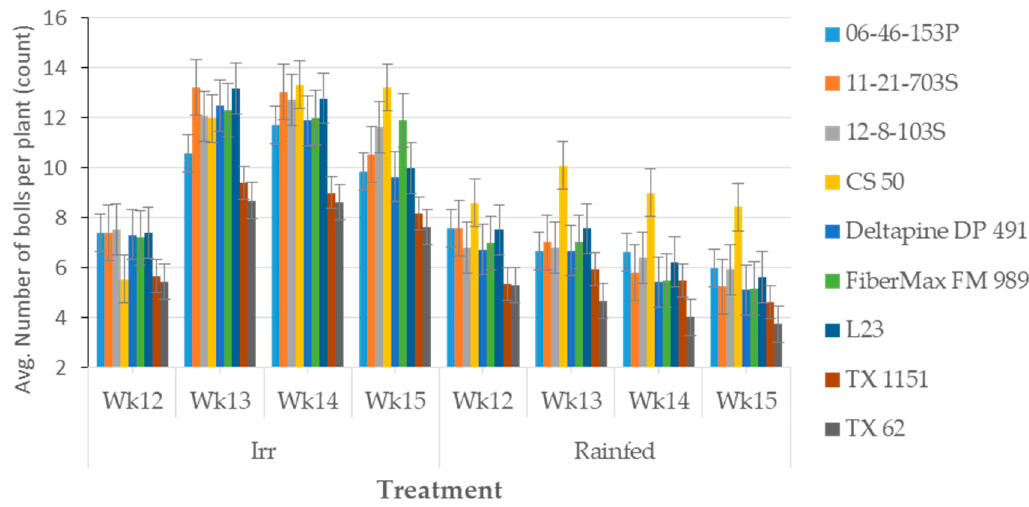
Figure 2. Variation in average number bolls per plant across weeks for upland cotton grown under irrigated and rainfed conditions. Wk., weeks; Irr., irrigated. Average number of bolls compared by subsampling of weeks 12 (Wk12) to weeks 15 (Wk15). Standard error (SE) bars were used to show the variations among genotypes in irrigated and rainfed trials. Overlapping SE bars show no differences between genotypes in irrigated and rainfed conditions.